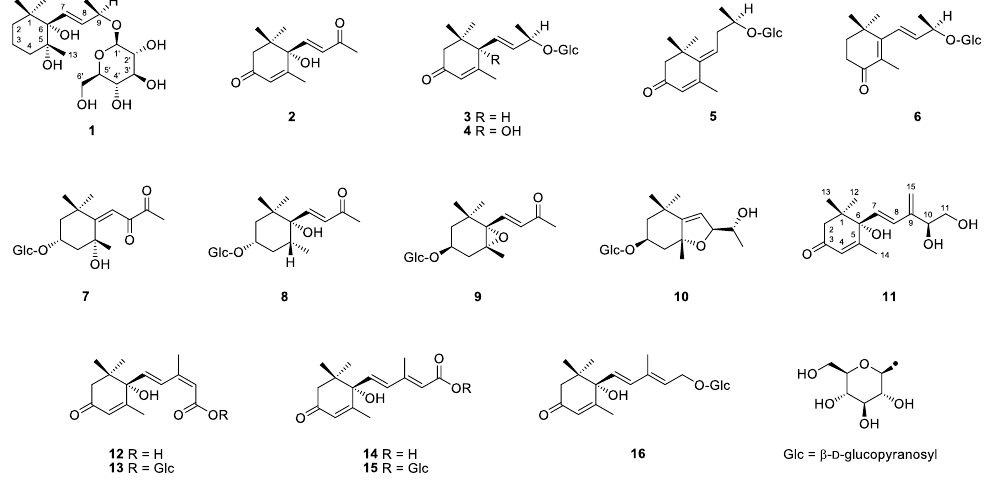
Figure 1. Chemical structures of compounds 1 – 16.